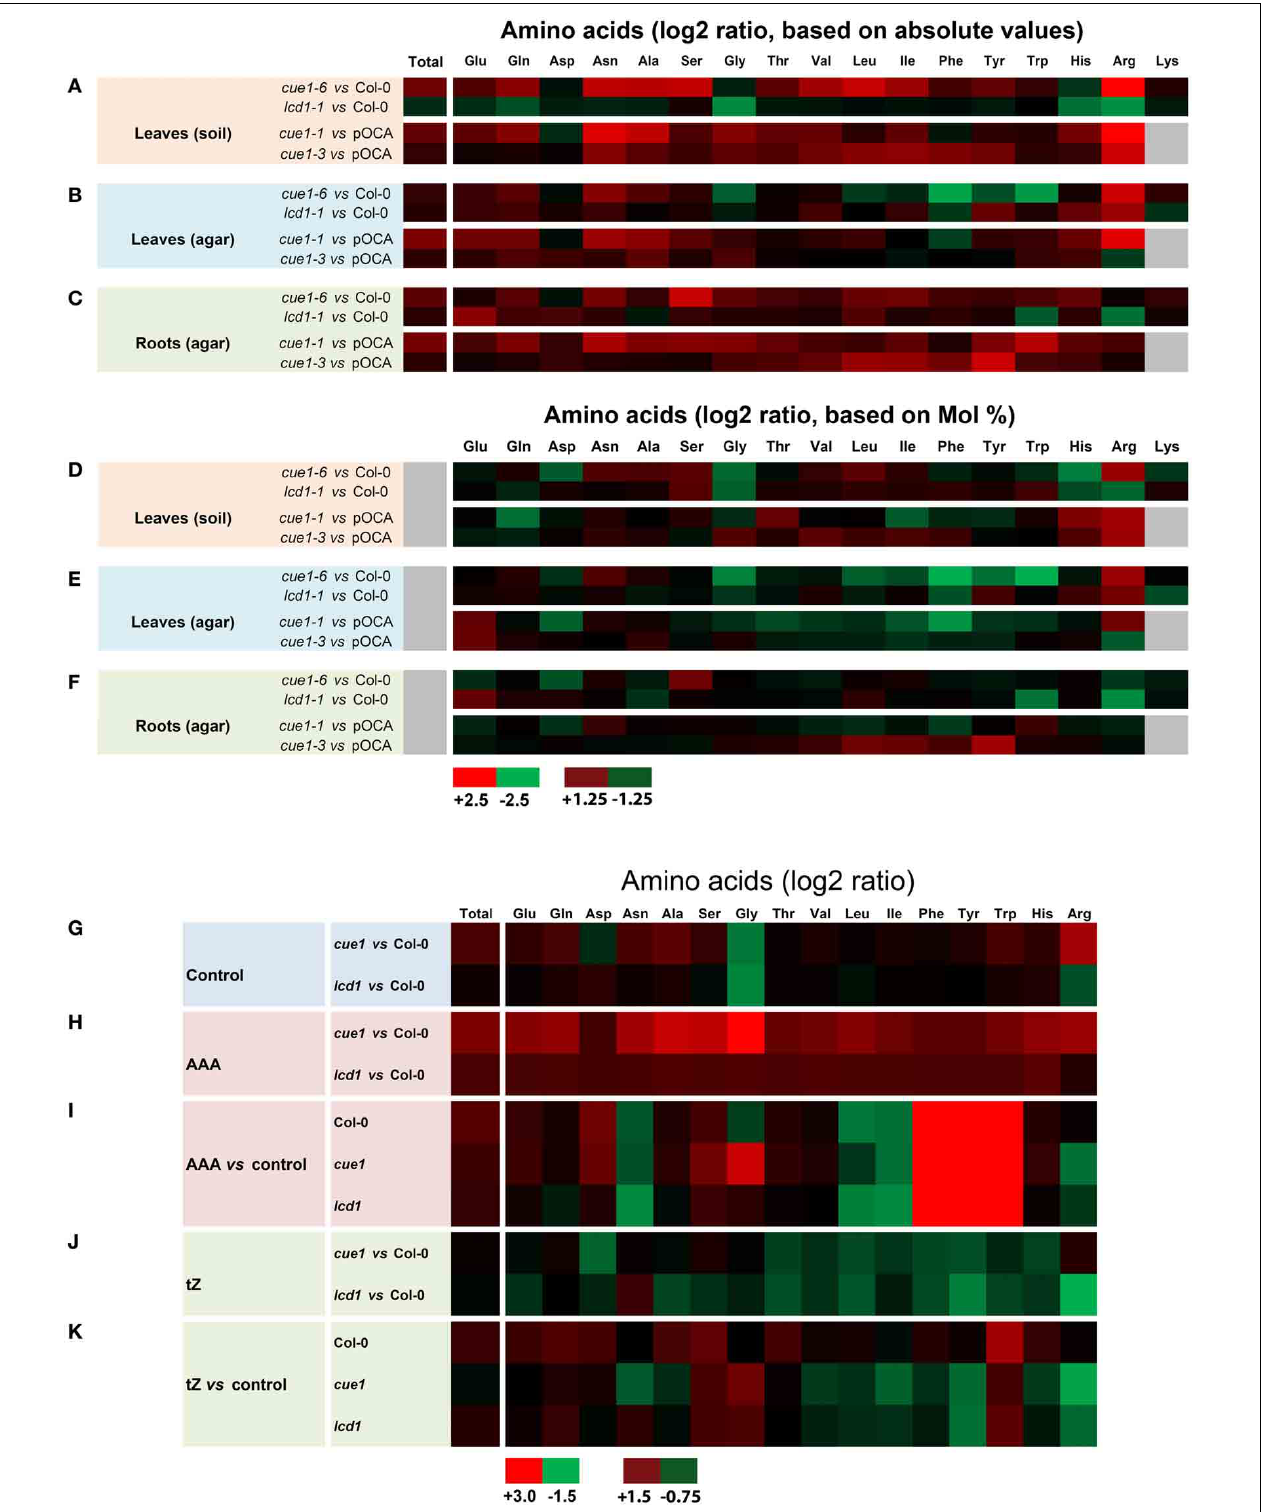
FIGURE 12 | Heatmap of amino acid spectra in wild-type and mutant plants. The contents of proteogenic amino acids were determined in leaves of wild-type (Col-0) or control plants (pOCA) as well as cue1-1 , cue1-6 and lcd1-1 mutants grown either on soil (A,D) or on ½MS agar (B,E) . The amino